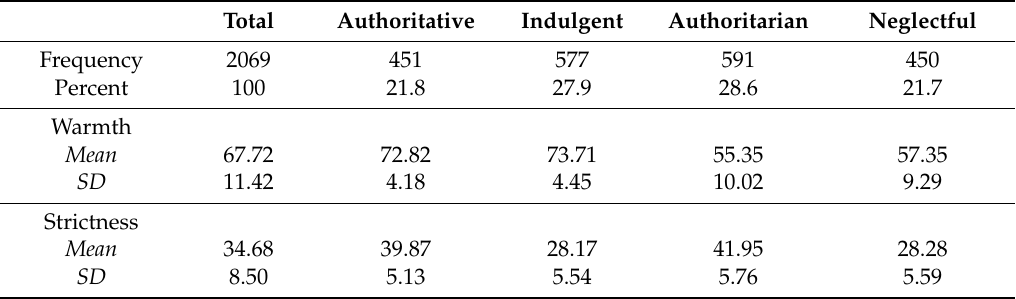
Table 1. Numbers of cases in parenting style groups, mean scores, and standard deviations for main measures of parental